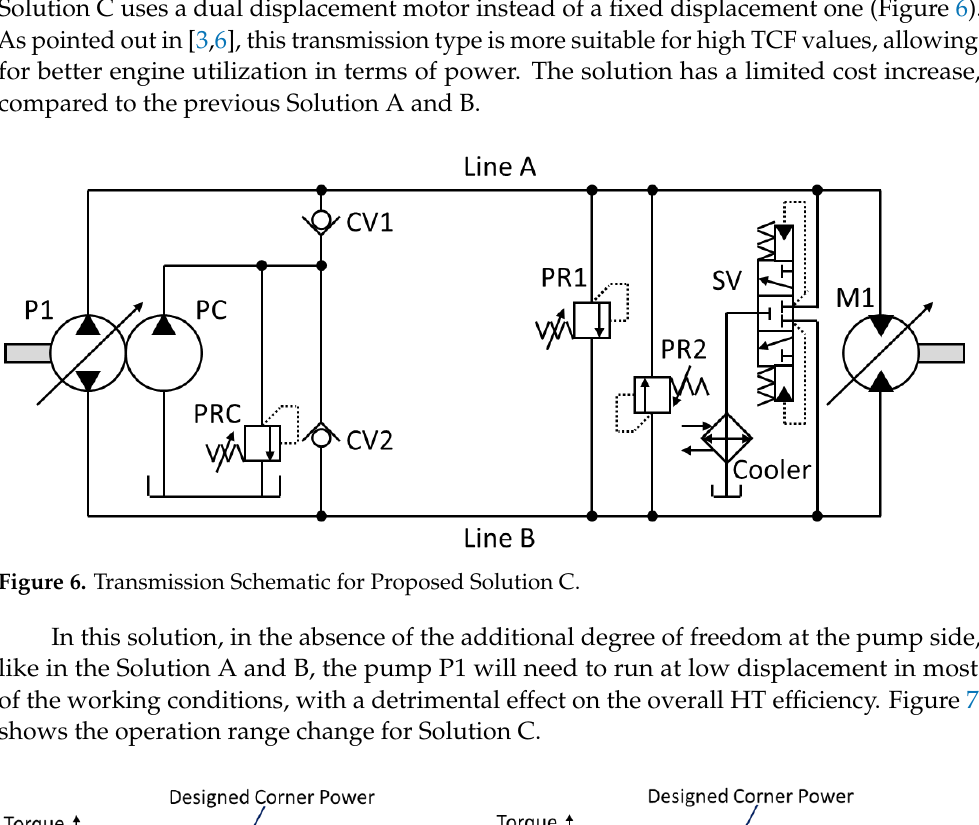
Figure 5. Transmission Schematic for Proposed Solution B.